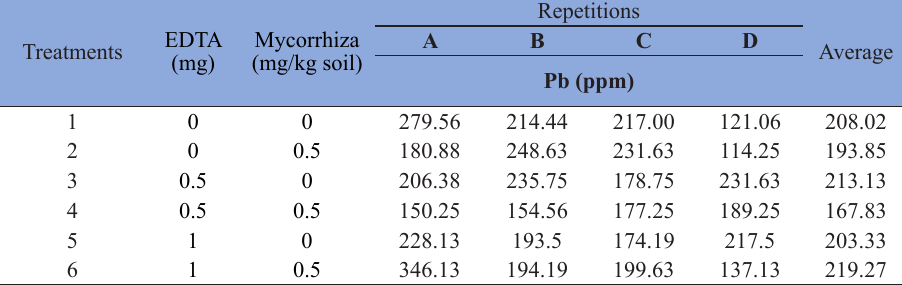
Table 6: Final concentrations of lead in the treated soils Treatments EDTA (mg)